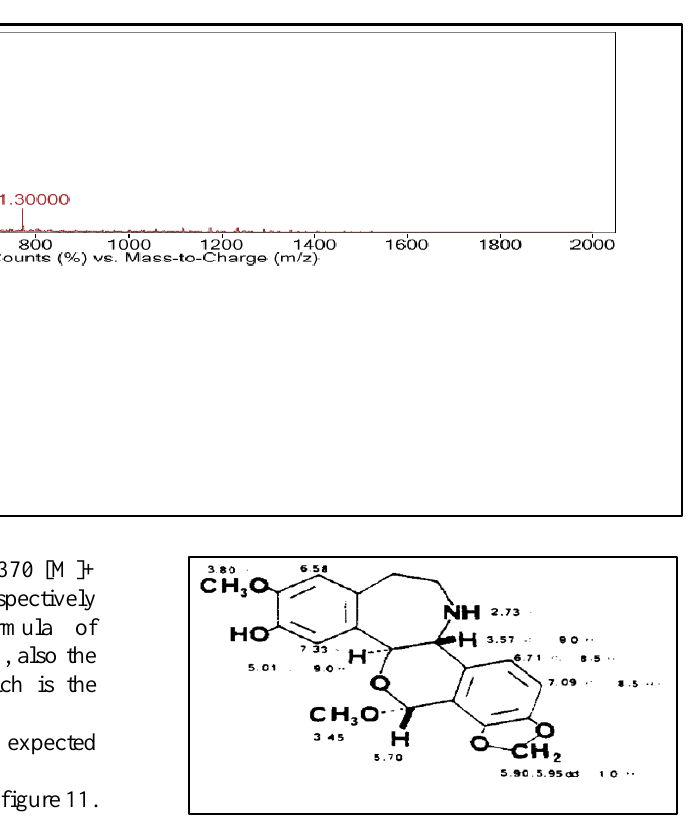
Figure 9. chemical structure of compound B indicated Papaverrubine C (Epiporphyroxine). The ʎmax spectrum and FTIR chart for compound B were shown in figure 10, 11 and table 2 .